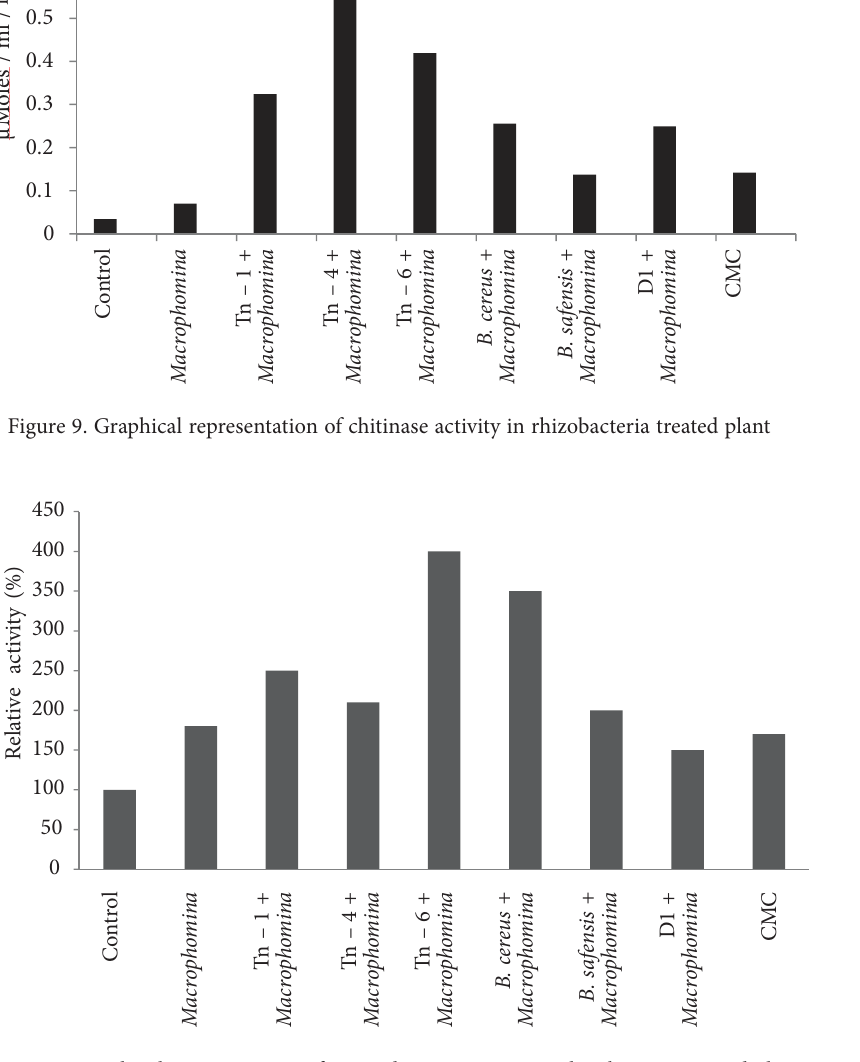
Figure 10. Graphical representation of peroxidise PO activity in rhizobacteria treated